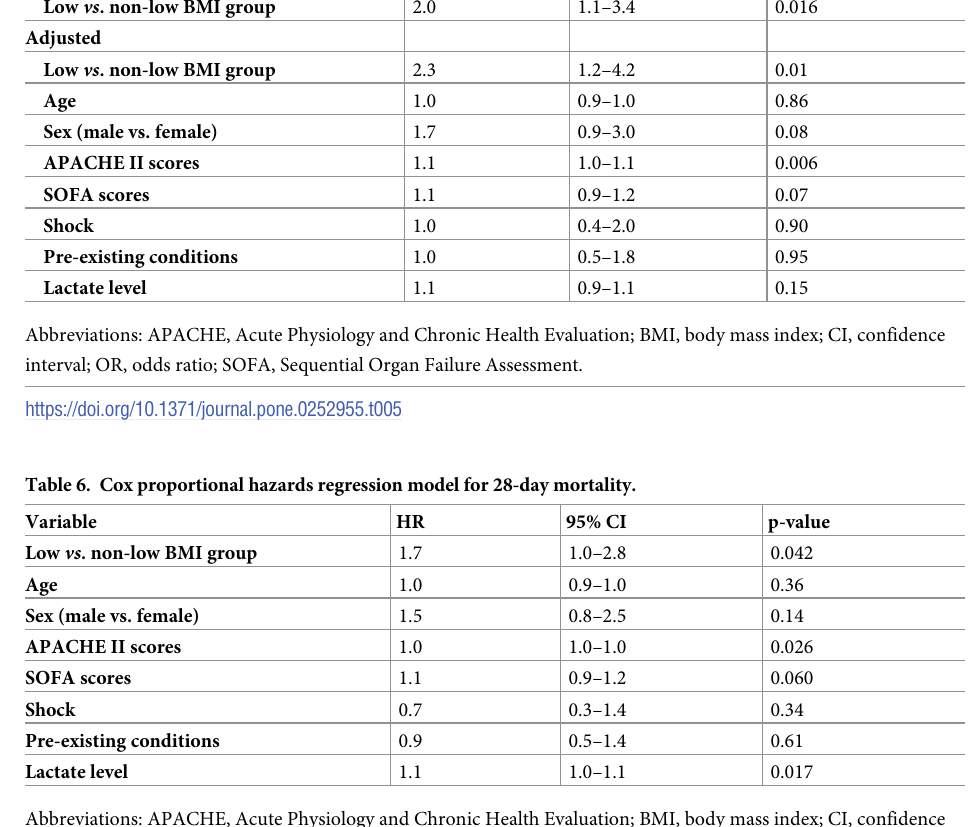
Abbreviations: APACHE, Acute Physiology and Chronic Health Evaluation; BMI, body mass index; CI, confidence interval; OR, odds ratio; SOFA, Sequential Organ Failure